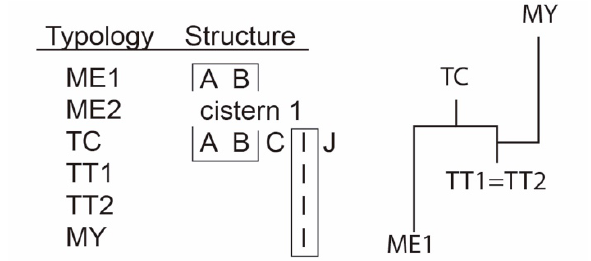
Figure 2. Table of typologies-structures and typology